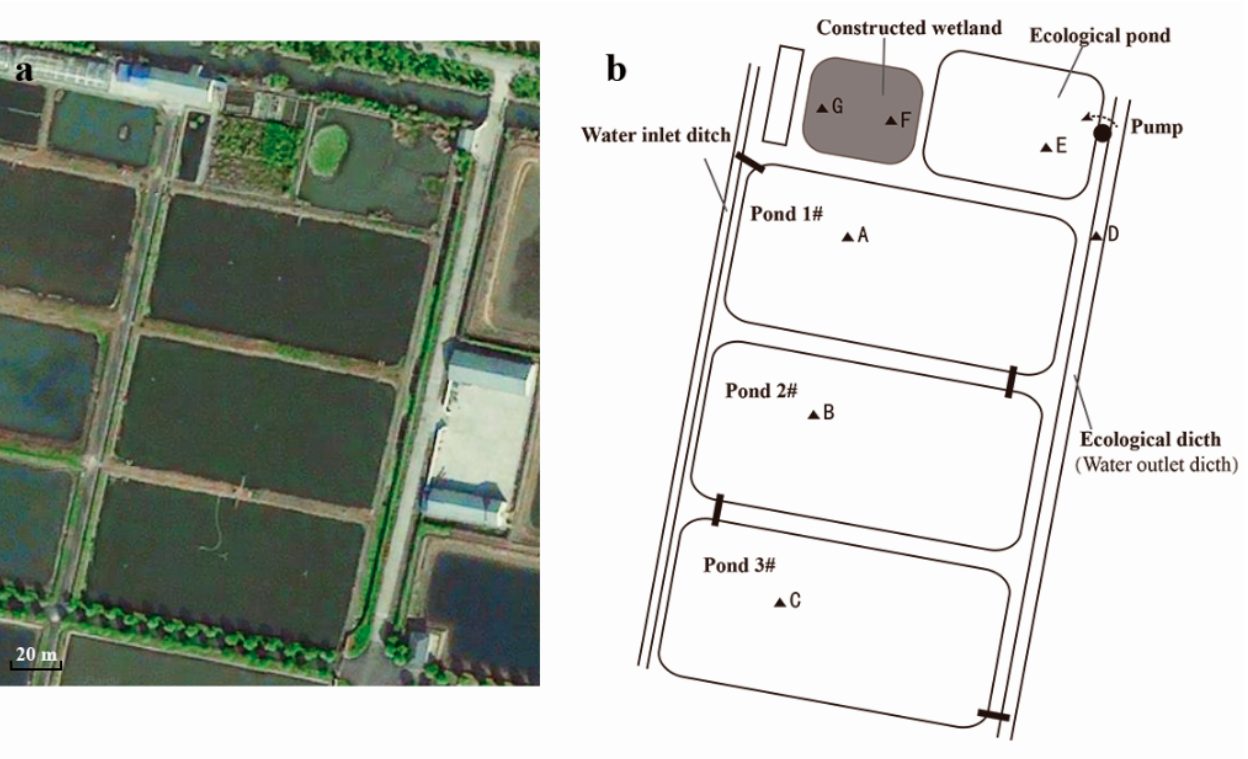
Figure 1. The RPAS and detailed description: ( a ) actual picture of the RPAS; ( b ) structural layout of the RPAS.